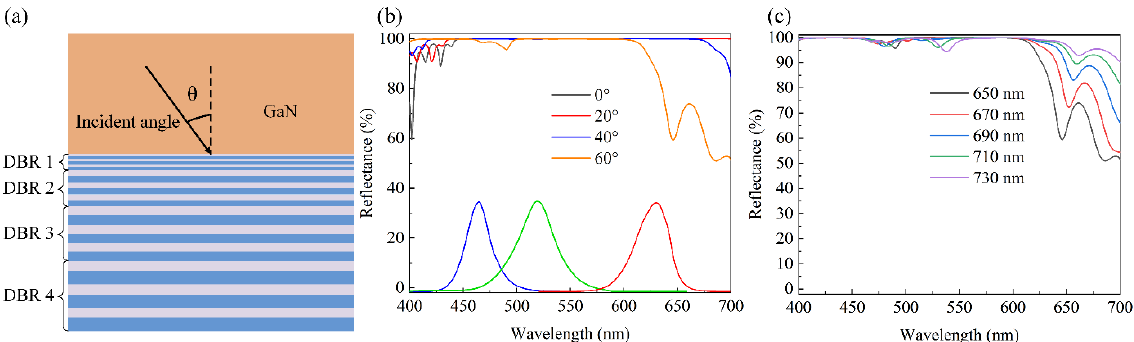
Figure 4. ( a ) Schematic illustration of DBR IV structure; ( b ) reflectance spectra of the DBR IV as a function of incident angle; ( c ) reflectance spectra of DBR IV with an added sub-DBR optimized for different central wavelengths at an incident angle of 60°.